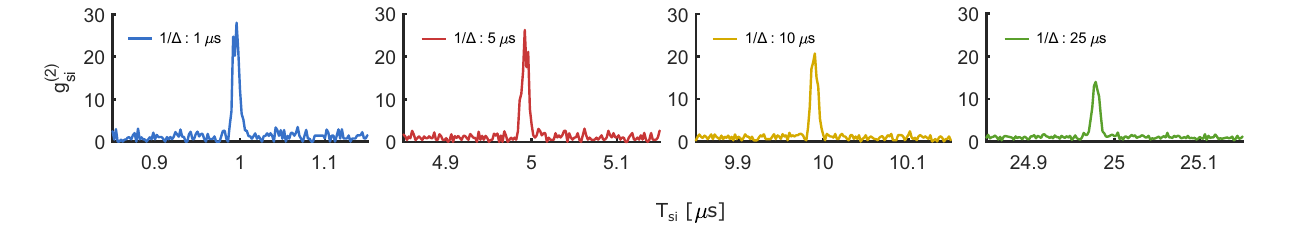
Fig. 2 | Non-classical correlations. Second-order cross-correlation function g ð 2 Þ si ð τ si Þ for different AFC storage times 1/ Δ =1 μ s, 5 μ s, 10 μ s, and 25 μ s. The cross- correlationfunctionpeaksattheexpectedemissiontimeof theAFCecho, τ si =1/ Δ ,